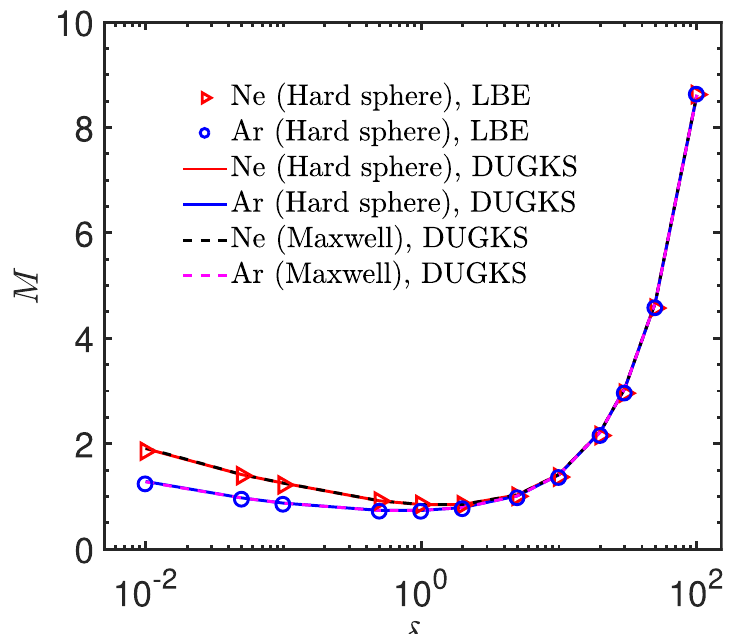
Fig. 18 Particle flux profiles versus 𝛿 in the Poiseuille flow of an equimolar Ne-Ar